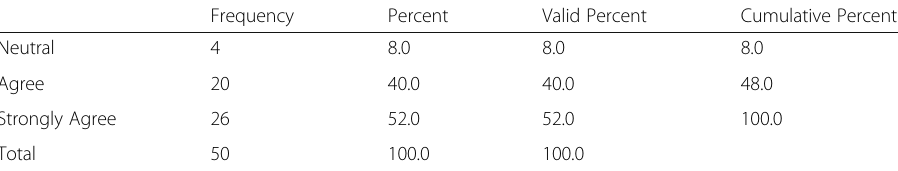
Table 10 Perceived ease of use